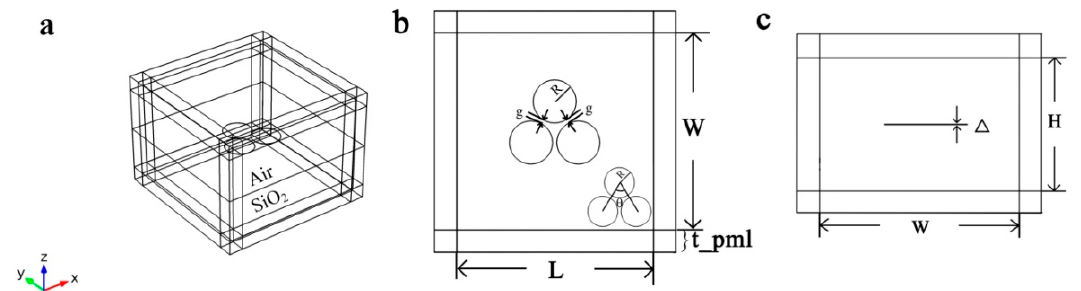
Figure 1. ( a ) Three-dimensional geometry of the proposed structure: ( b ) vertical view, ( c ) left view. Here, the radius ( R ), height ( ∆ ), and chemical potential ( μ c ) of graphene are 50 nm, 0.335 nm, and 0.5 eV, respectively. θ is the vertex angle of trimeric plasmonic molecules (PMs), shown in the inset of (b), and g = 1 nm is the distance between the individual plasmonic “atoms.” Outside the graphene is the free space, where the length ( L ), width ( W ), and height ( H ) of the computation window are 450 nm, 450 nm, and 300 nm,